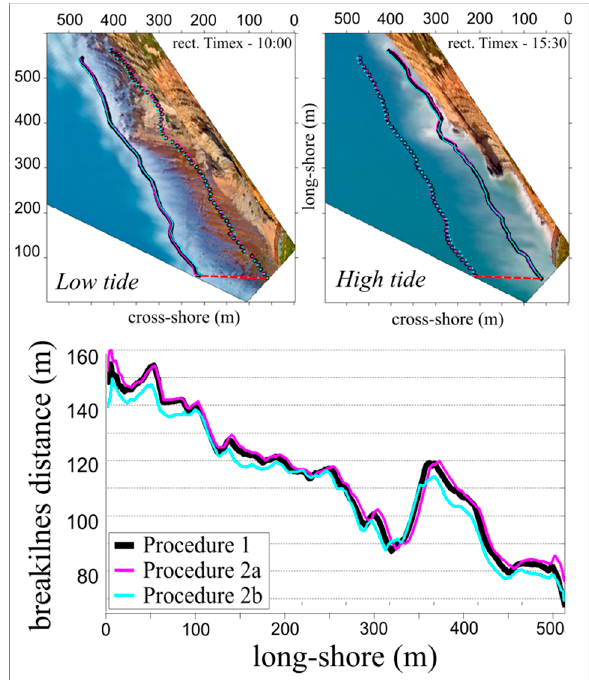
Figure 11. Above : breaklines detected on the rectified Timex images generated from the three presented Procedures, during low and high tide. Red dashed line shows the distance between breaklines found over the two tidal conditions. Below : differences between two breaklines detected during low and high tide for each Procedure.